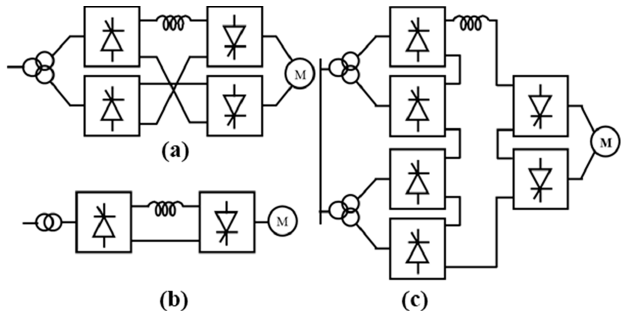
Figure 3. Example of LCI configurations: ( a ) 12/12-pulse, ( b ) p/q-pulse and ( c ) 24/12-pulse